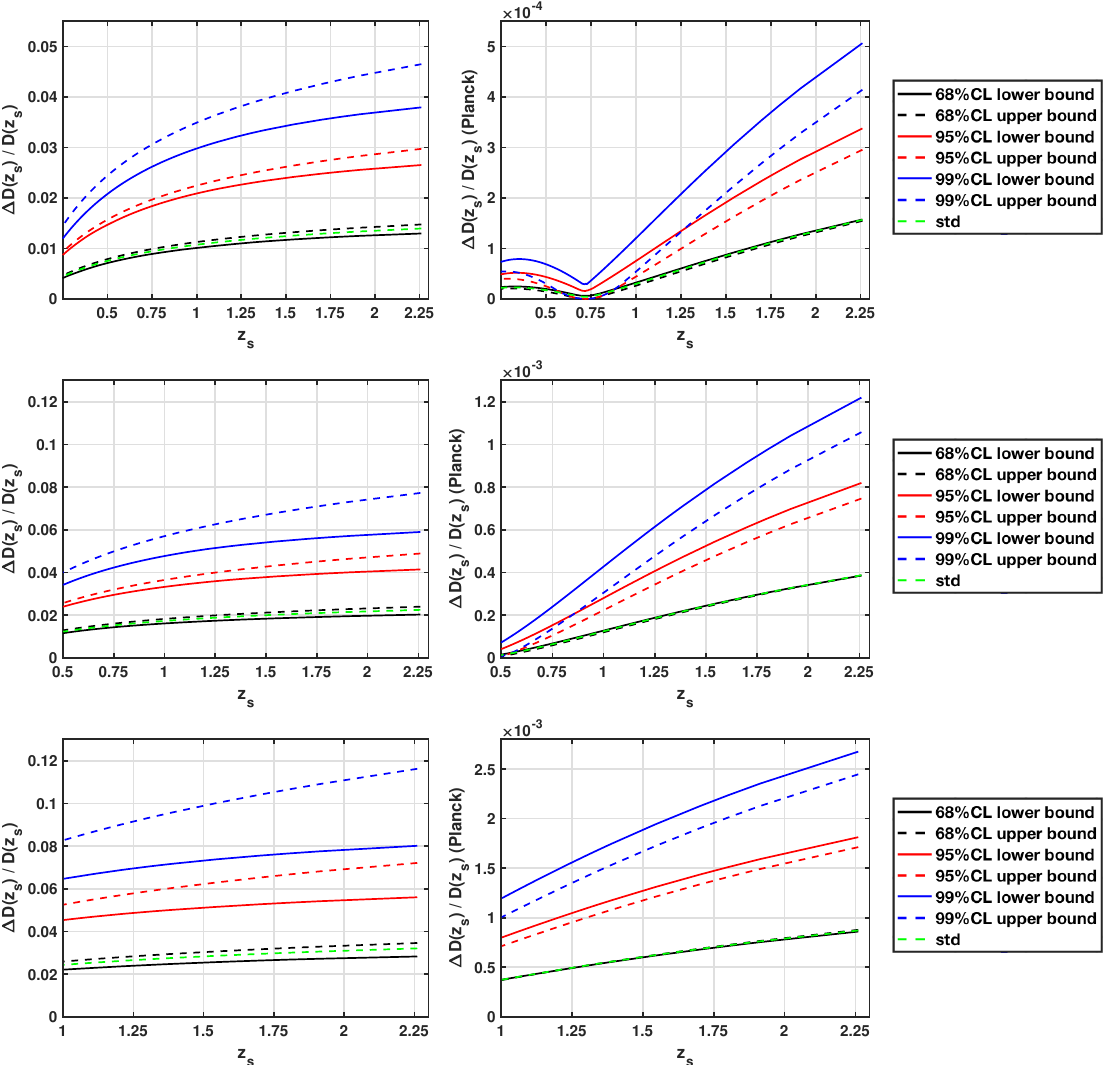
Figure 7. Comparison between the relative imprecision of the data-based lensing distance ratio ( left ) and the relative imprecision of the Planck-model-based distance ratio ( right ) for lens redshifts z l = 0.25 ( top row ); z l = 0.5 ( centre row ); z l = 1.0 ( bottom row ). D ( z s ) is the lensing distance ratio defined in Equation (37) for fixed z l . Note the difference in the orders of magnitudes on the